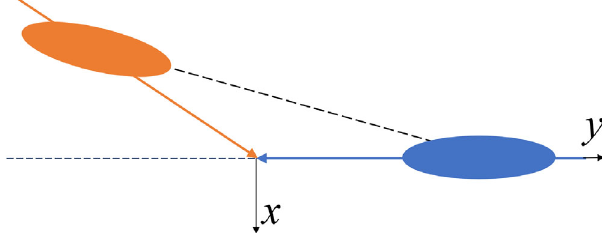
1. An optimal geometry — crab-crossing scheme: two colliding beams are oriented along the velocity of approach (dashed